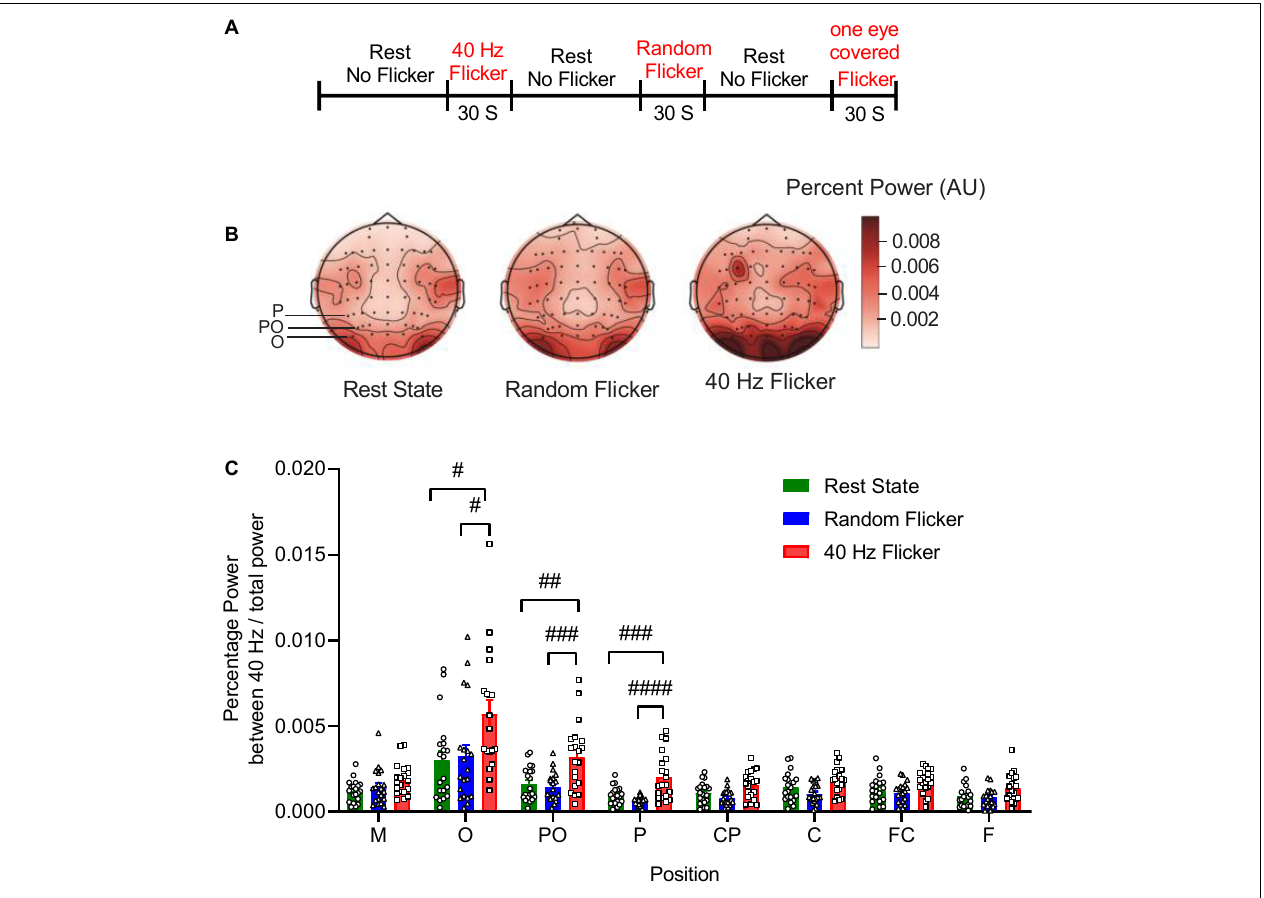
FIGURE 1 | EEG sequence and PSD analysis. Panel (A) depicts the experimental schema of light flicker stimulation and EEG sequence. Panel (B) is a graphical representation of the intensities of EEG signals in the anatomical brain regions, illustrating the topographic maps of PSD change (Left: rest state; Middle: random flicker; right: 40 Hz light stimulation). Selected positions of O, PO, and P were indicated on the rest state map. The scale bar represents an arbitrary unit (A.U.). EEG recordings were analyzed, and the percentage of the power spectrum between 40 Hz and the total power was calculated from different brain regions as indicated in panels (C) . Statistical comparisons between the three conditions (rest state, random flicker, and the 40 Hz light stimulation) were performed using one-way ANOVA with multiple comparisons using FDR correction using the two-stage linear step-up procedure of Benjamini, Krieger, and Yekutieli (GraphPad Prism v8). Significant groups were shown in panel (C) . #, ##, ###, and #### indicate the FDR adjusted P < 0.05, P < 0.01, P < 0.001, and P < 0.0001, respectively.